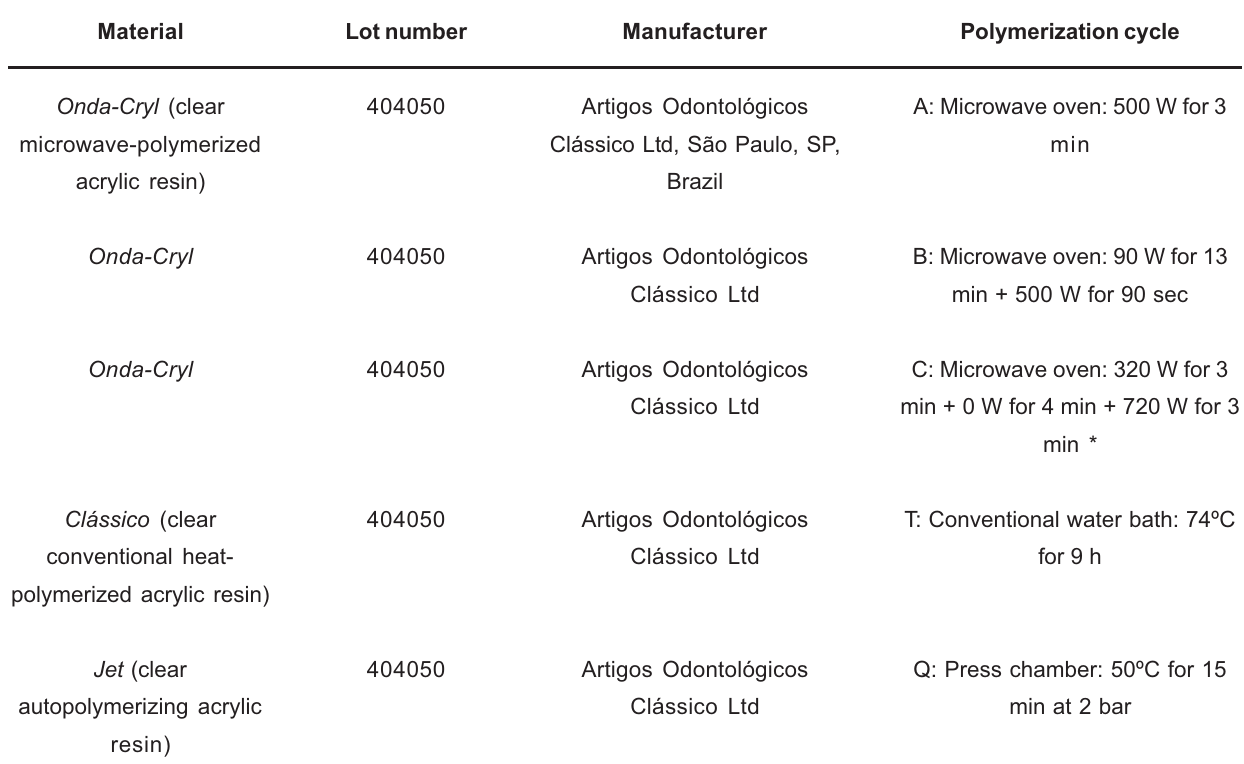
* Cycle recommended by Onda-Cryl